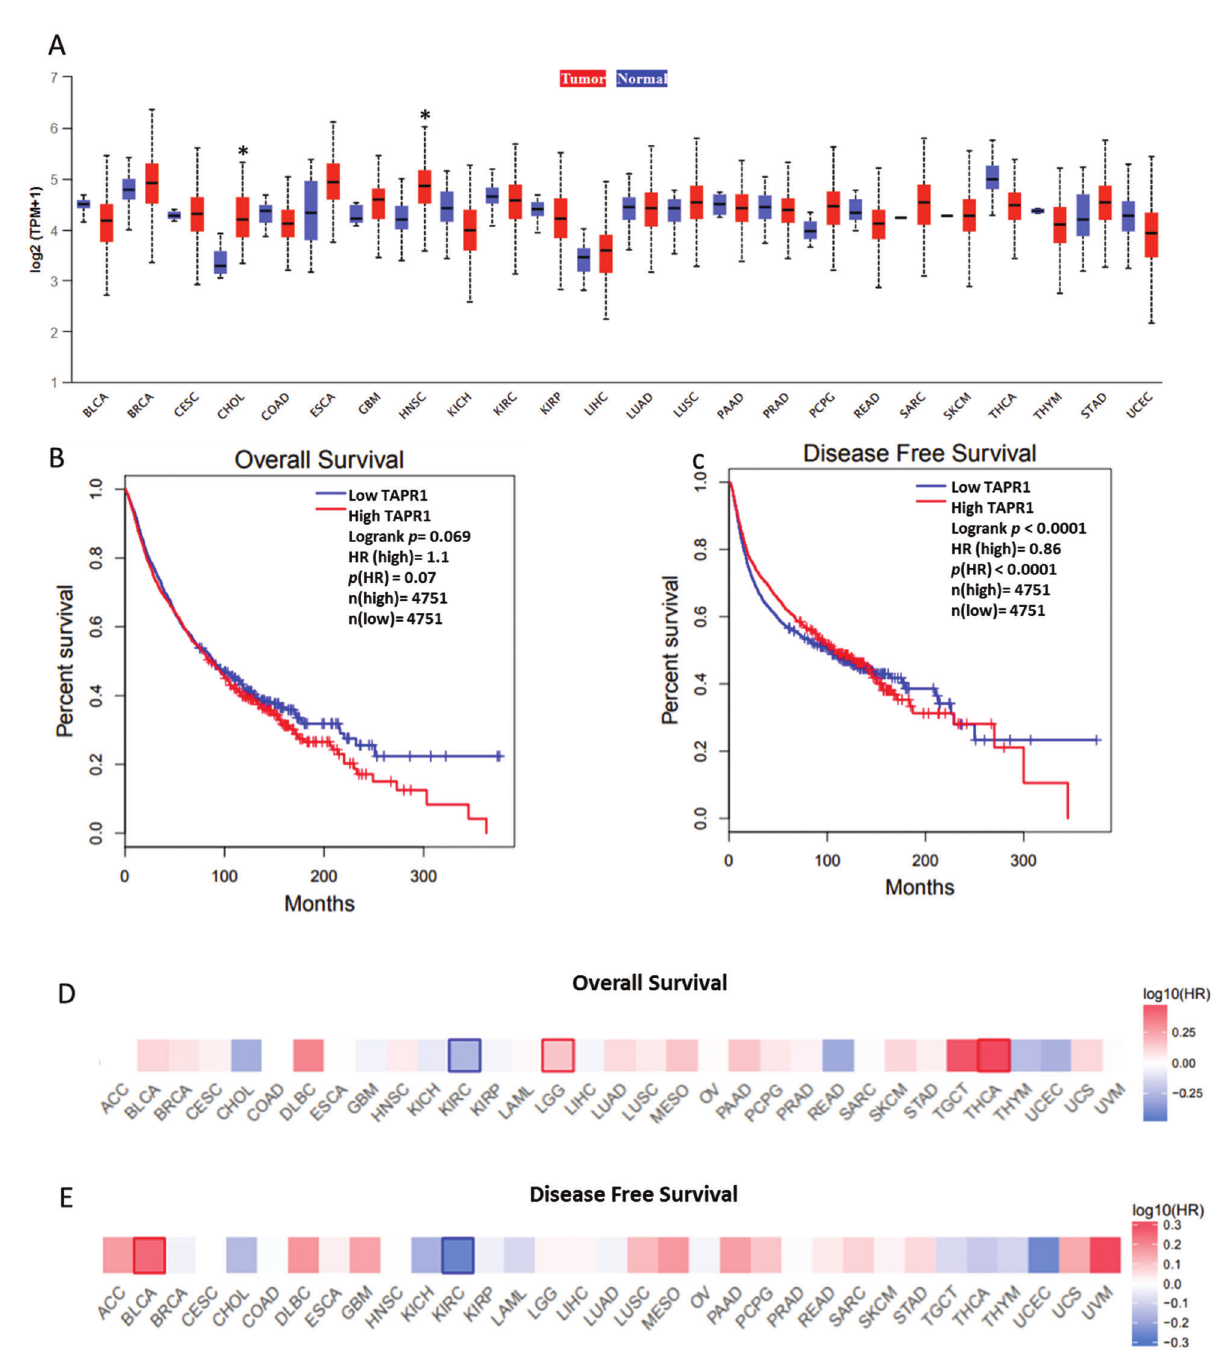
Figure 2 - TAPR1 and cancer prognosis. (A) Comparison of TAPR1 expression between normal and cancer tissues. The boxplots are grouped in pairs for each cancer with the control tissue in blue (left) and the tumor tissue in red (right). (B) Overall survival and (C) disease-free survival considering all cancer samples. (D) Hazard ratio heat map of overall survival and (E) disease-free survival considering each cancer individually. Statistically significant results (Mantel–Cox test) are highlighted with blue (downregulated) or red (upregulated) borders. * p o 0.05; HR=hazard